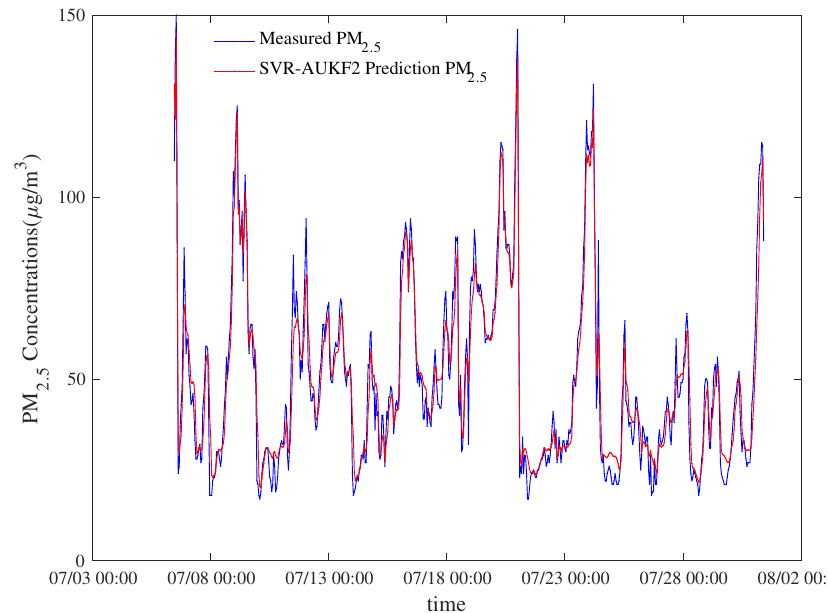
period. The errors will be produced in some point of time period. The SVR-AUKF1 method cannot predict PM 2.5 concentration accurately in the whole time period. The predicted PM 2.5 concentration value by SVR-AUKF2 is given in Figure 9.